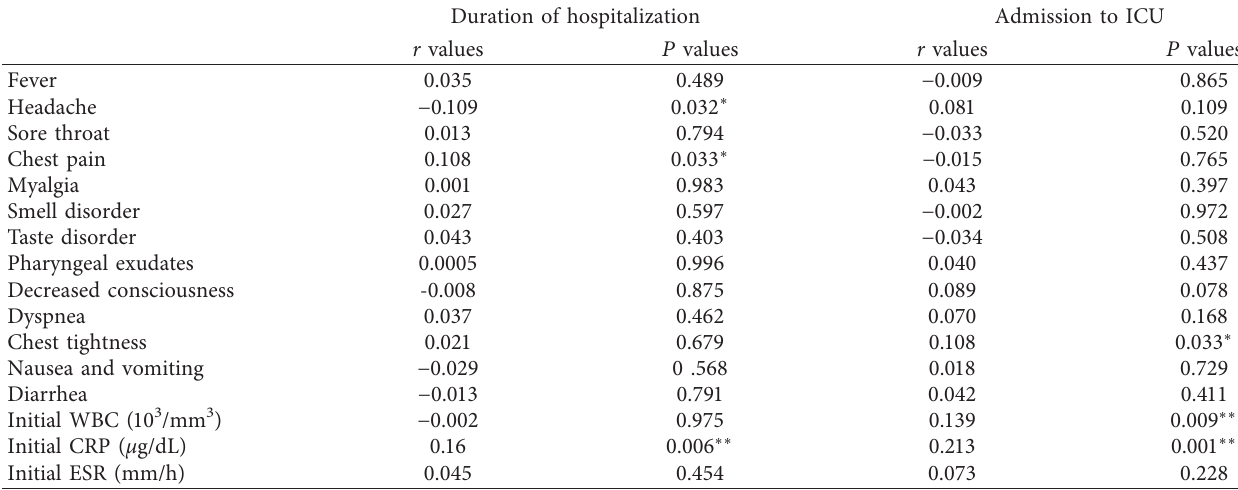
Table 3: Pearson’s correlation coefficients between clinical manifestations and laboratory findings with hospitalization duration and admission to